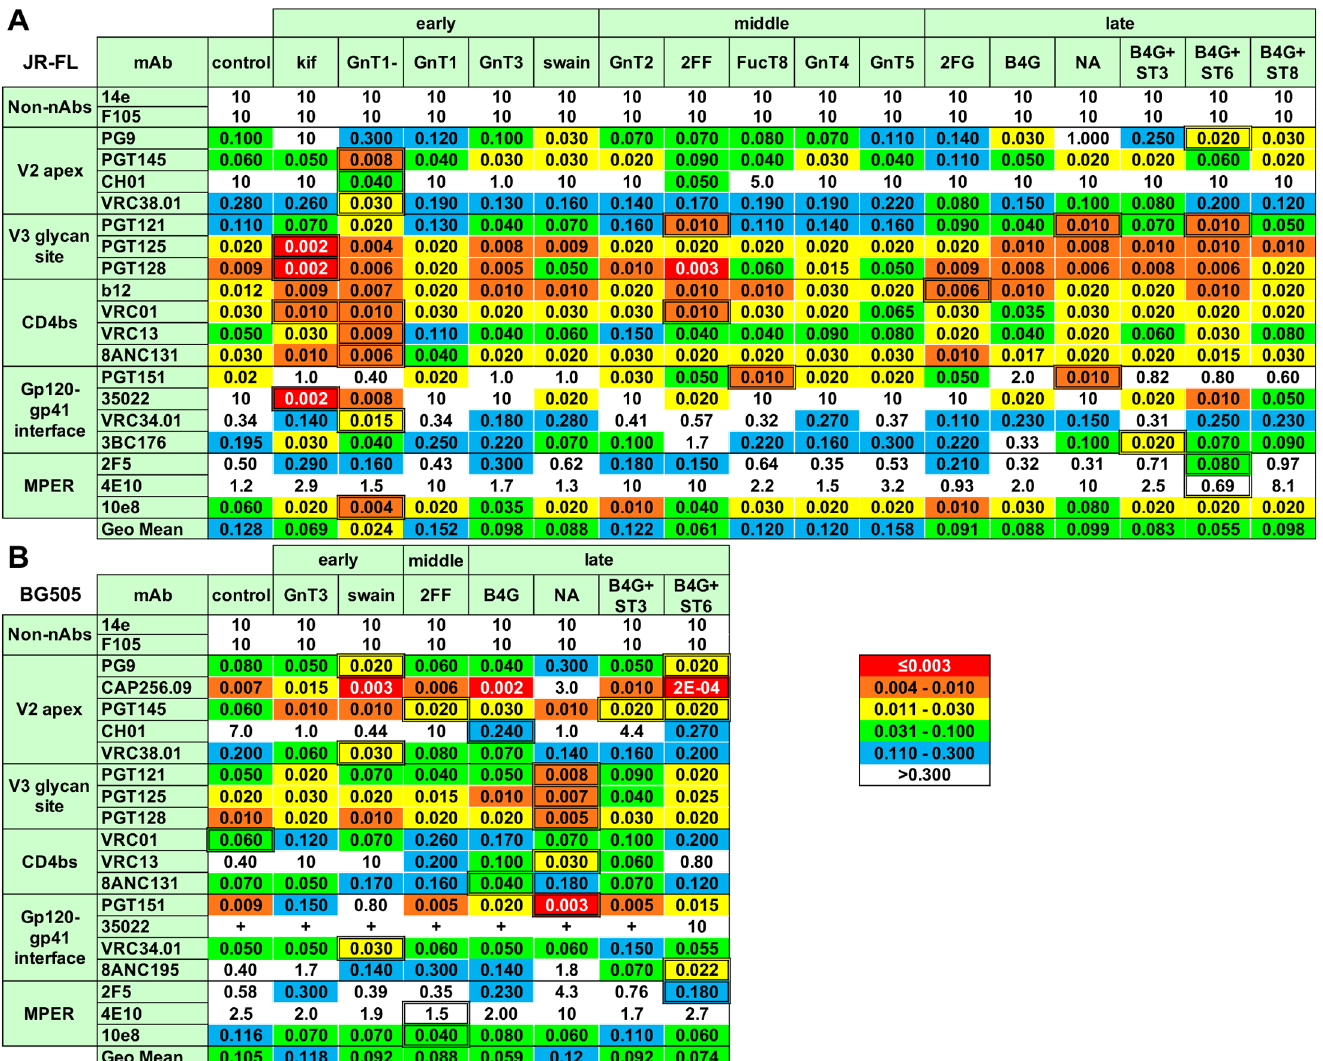
Fig 2. Effects of GE on bnAb neutralization IC50s. Neutralizing IC50s for each control and GE-modified A) JR-FL and B) BG505 PVs are shown in μ g/ml. The most sensitive glycoform for each nAb is boxed. JR-FL neutralization assays for mAb 3BC176 used the N88A mutant. Each assay was performed at least in duplicate. In many cases, BG505 neutralization by mAb 35O22 was insufficiently saturating to reach an IC50 and is denoted by a "+". Geometric mean IC50s per treatment are shown, omitting data for 14e, F105 and instances of 35O22 "+". This Fig is linked to Fig 3, S2 and S6 Figs. Abbreviations: B4G = B4GALT1, ST3 = ST3GAL4, ST6 = ST6GAL1, ST8 =